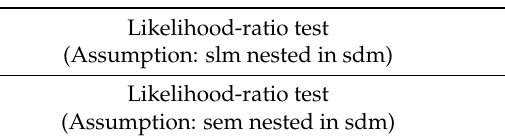
Table 2. Spatial model selection